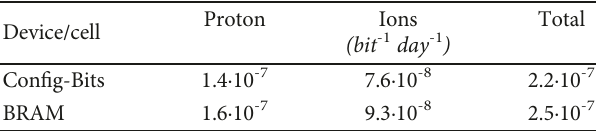
Table 5: SEU rates for Virtex-II.